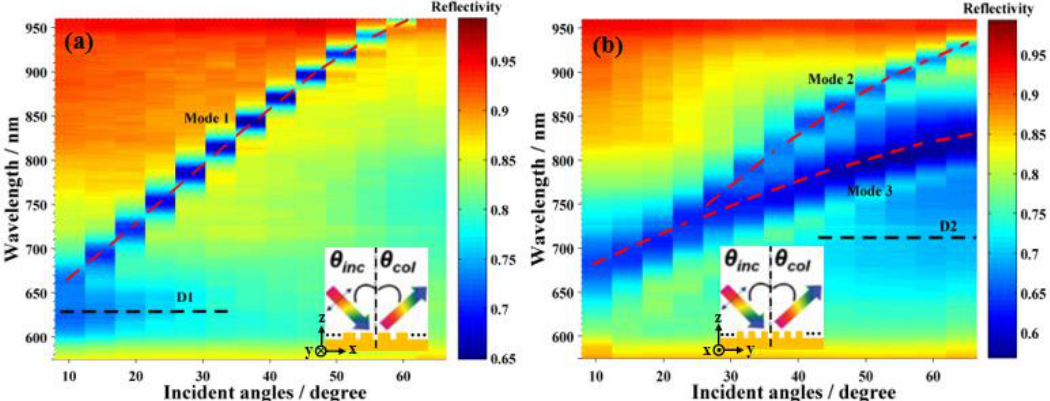
Figure 3. Angle-resolved reflection spectrum of the Au NHAs at different structural orientation angles ( a ) ϕ = 0° and ( b ) ϕ = 90°. Insets are the optical measurement configuration.